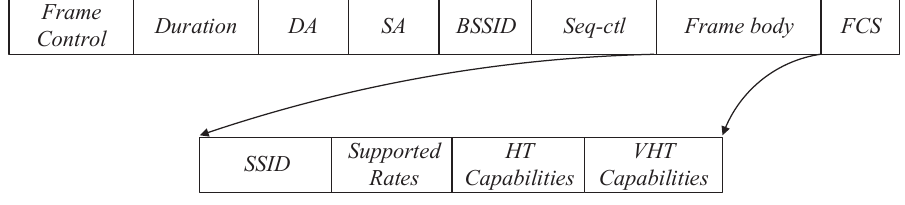
Figure 2. Basic structure of 802.11ac probe request